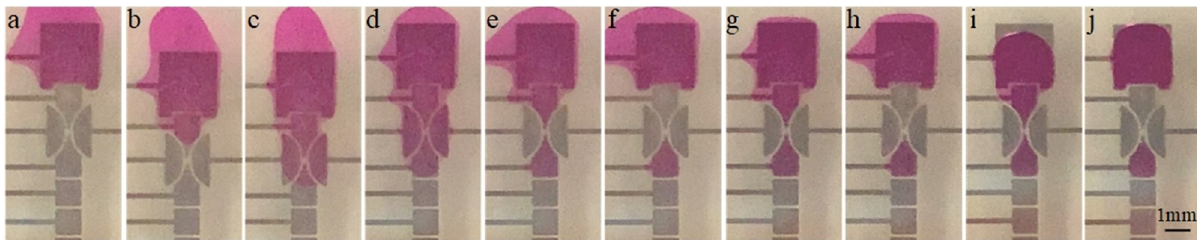
Figure 5: Series of video frames about droplet dispensing using the optimized electrodes scheme with the cutting electrodes radius R = 1.2 mm ( Video S1 ) ; ( a – f ) The fi rst droplet was generated; ( g and h ) The fi fth droplet was dispensed; ( i and j ) The tenth droplet was dispensed.